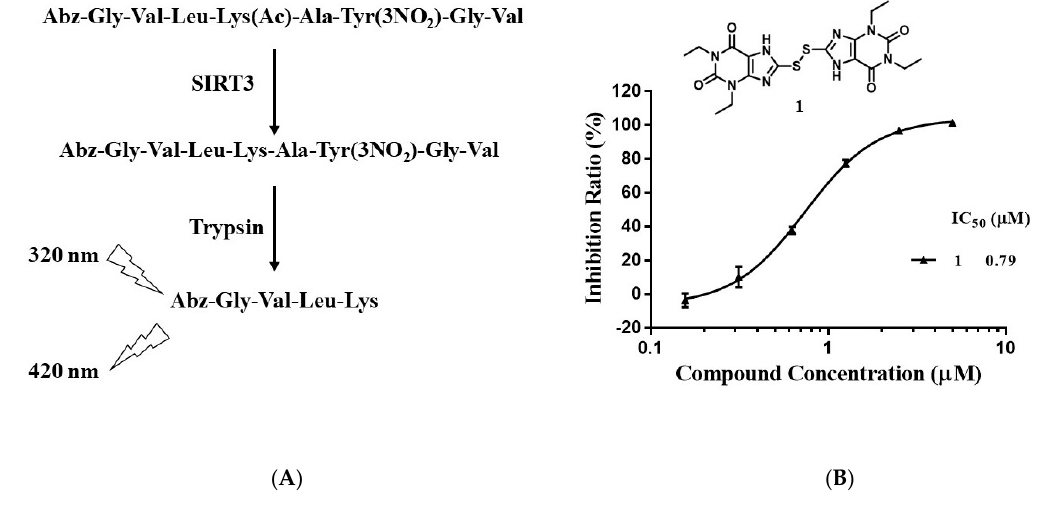
Figure 2. Discovery of SIRT3 inhibitors. ( A ) Principle of the enzyme assay. ( B ) Chemical structure and IC 50 of compound 1 .